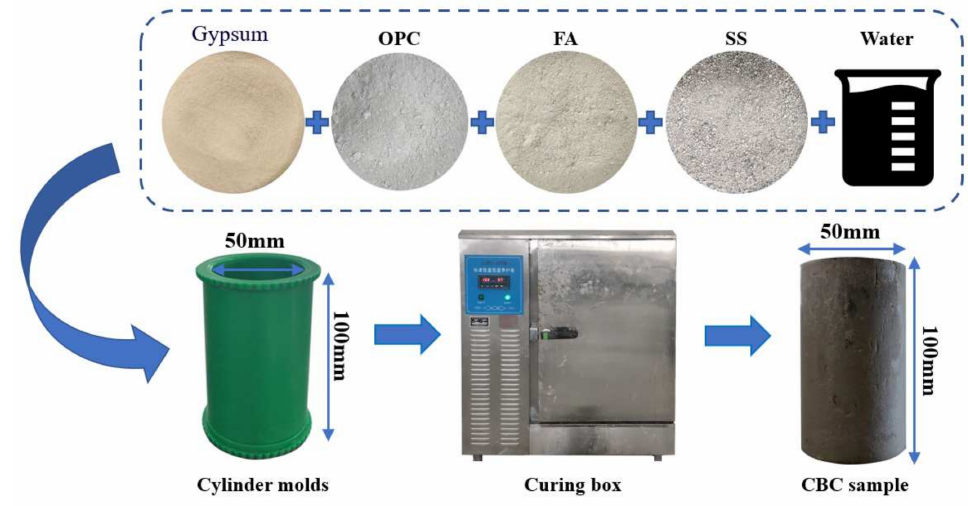
Figure 3. Flow chart of CBC specimen preparation. Table 3. Mixture proportions of the CBC samples used in the experiments.